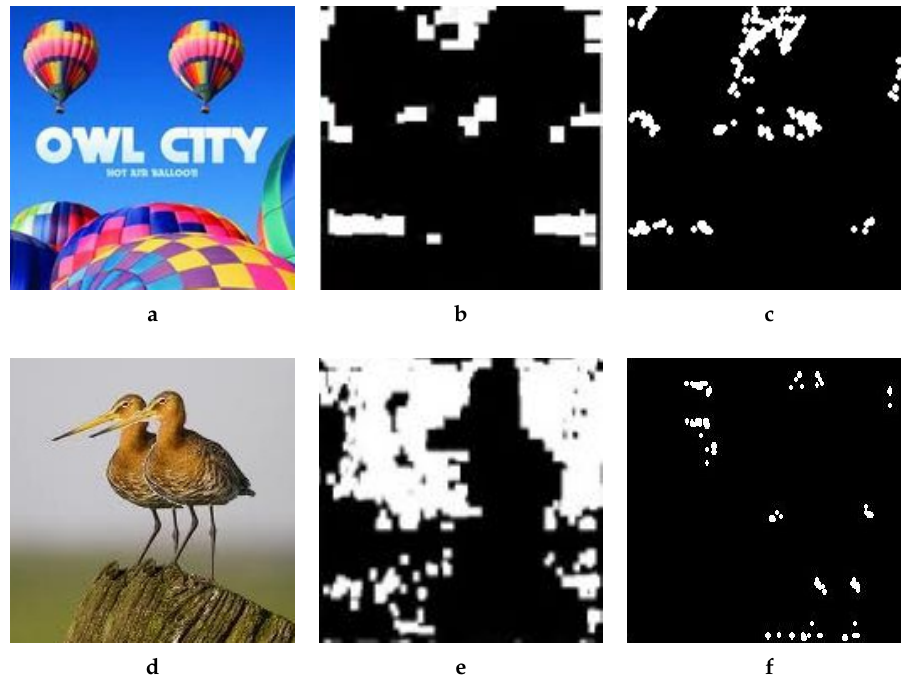
Figure 10. Forgery detection results by two benchmark methods. ( a ) Forged, ( b ) Mahmood, ( c ) Meena, ( d ) Forged, ( e ) Mahmood, ( f ) Meena.